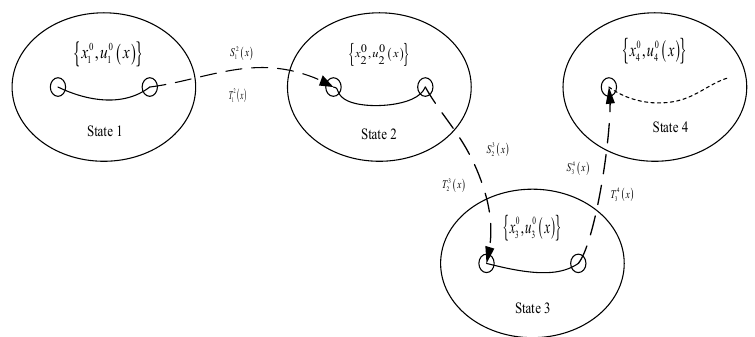
Figure 6. Mode transitionfrom pure electric to hybrid drive.